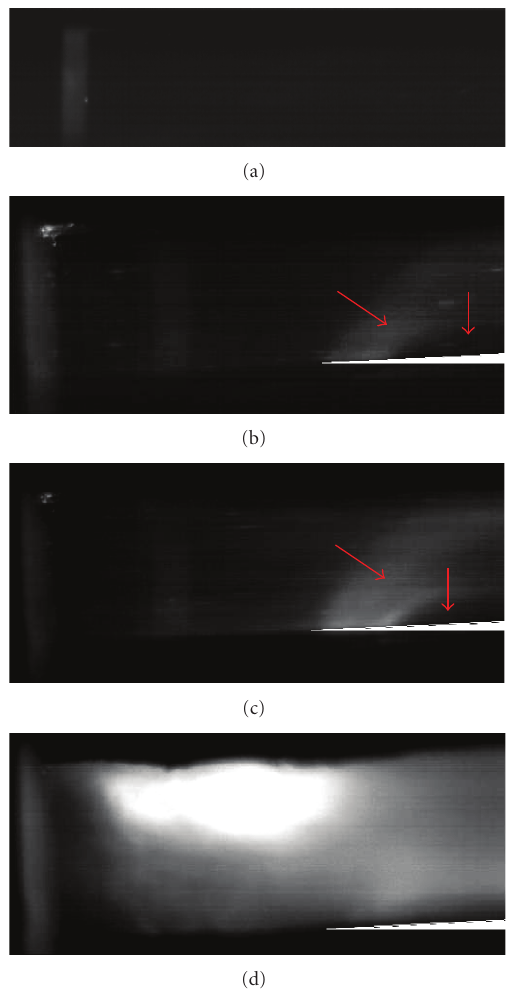
Figure 15: Snapshots of shock wave (HTPB slab @ AOA = 7 ◦ ) (a) before event ( t = 0 second), (b) shock wave arrived (dir.: → , t = 11 . 1 milliseconds), (c) shock wave through (dir.: → , t = 11 . 7 milliseconds), (d) ref. Shock (dir.: ← , t = 14 . 1 milliseconds).